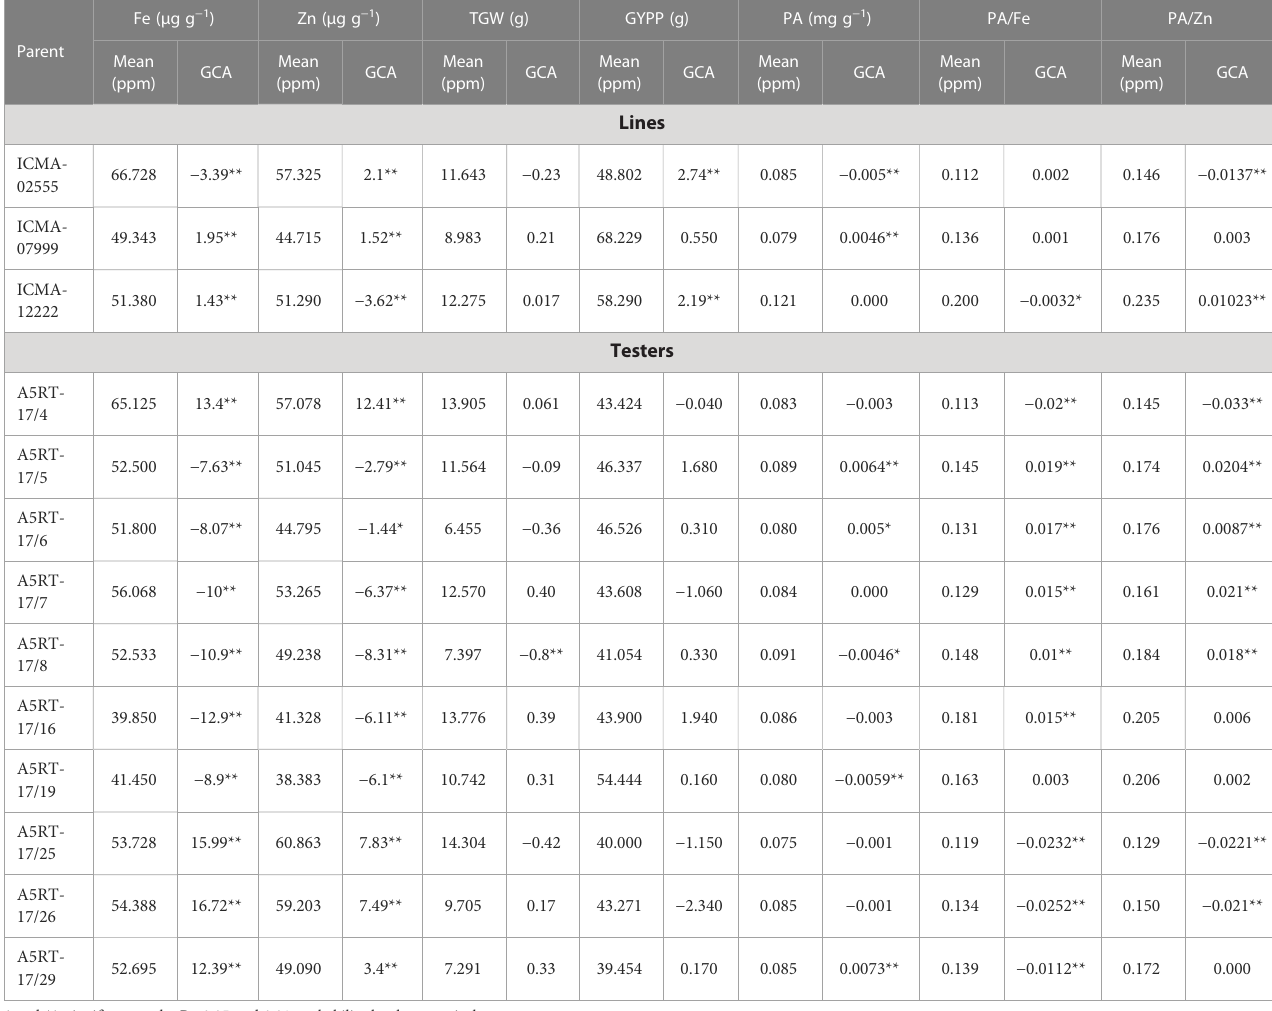
TABLE 3 Performance per se of the lines and testers and their general combining ability (GCA) effects for traits studied in pearl millet across two environments. Fe (µg g − 1 Parent